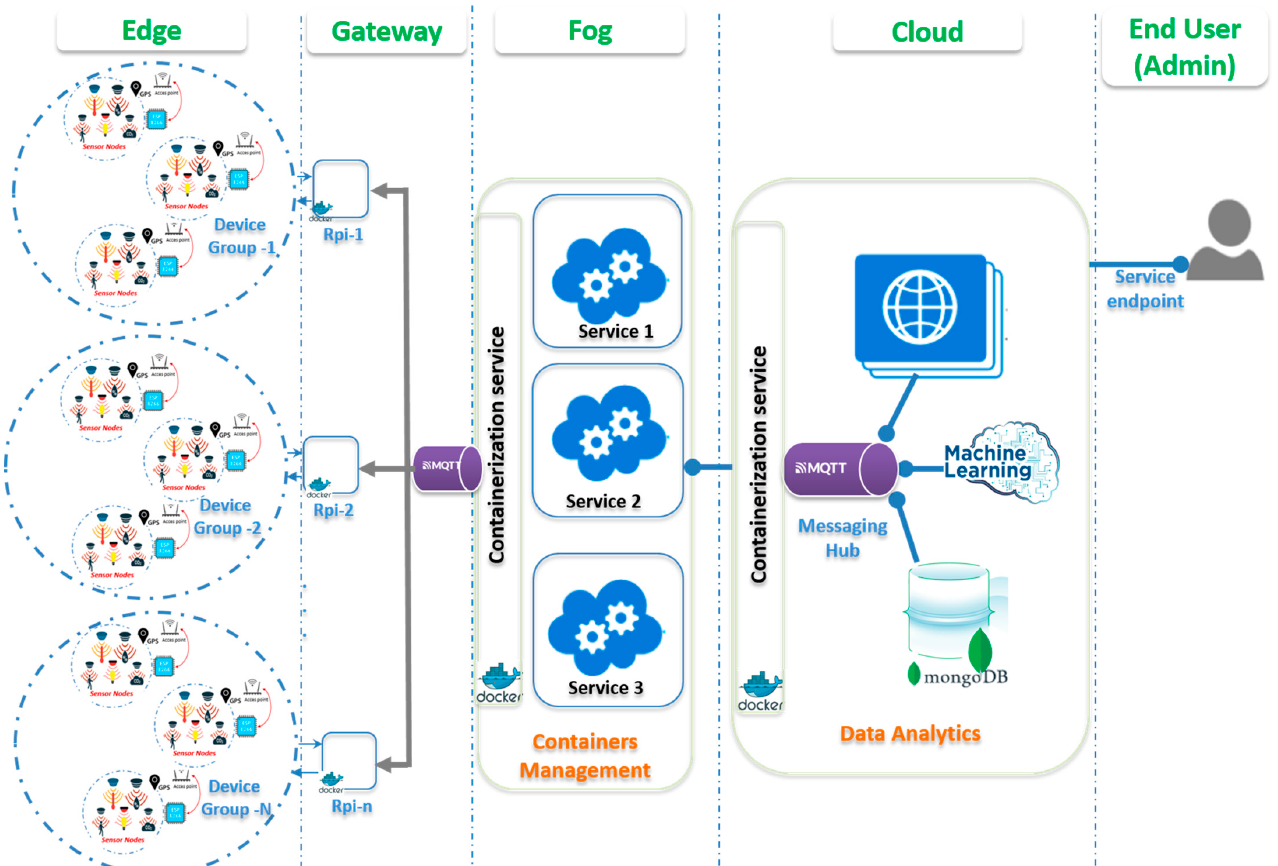
Figure 1. Proposed Deployment Architecture.